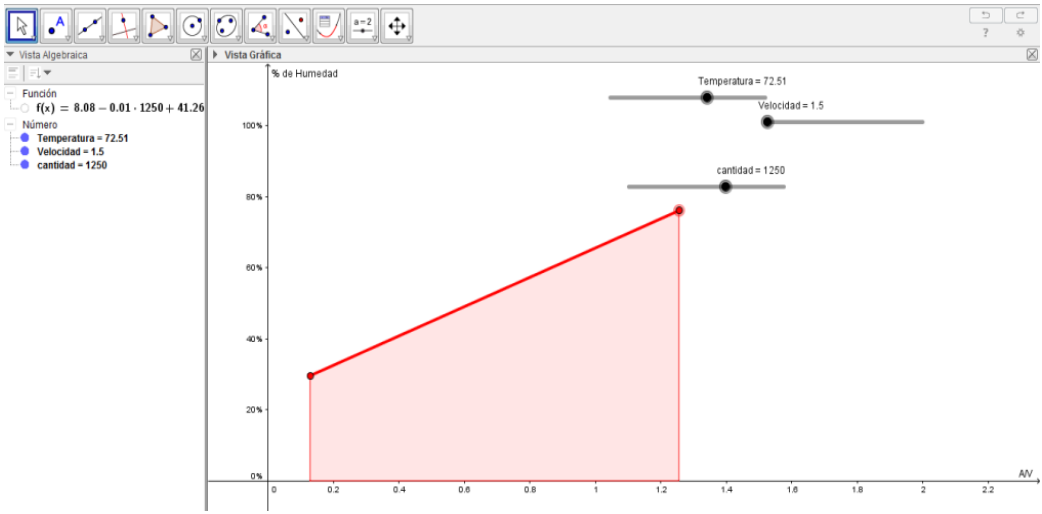
Figure 3. The relationship of %H vs. area/volume (A/V).